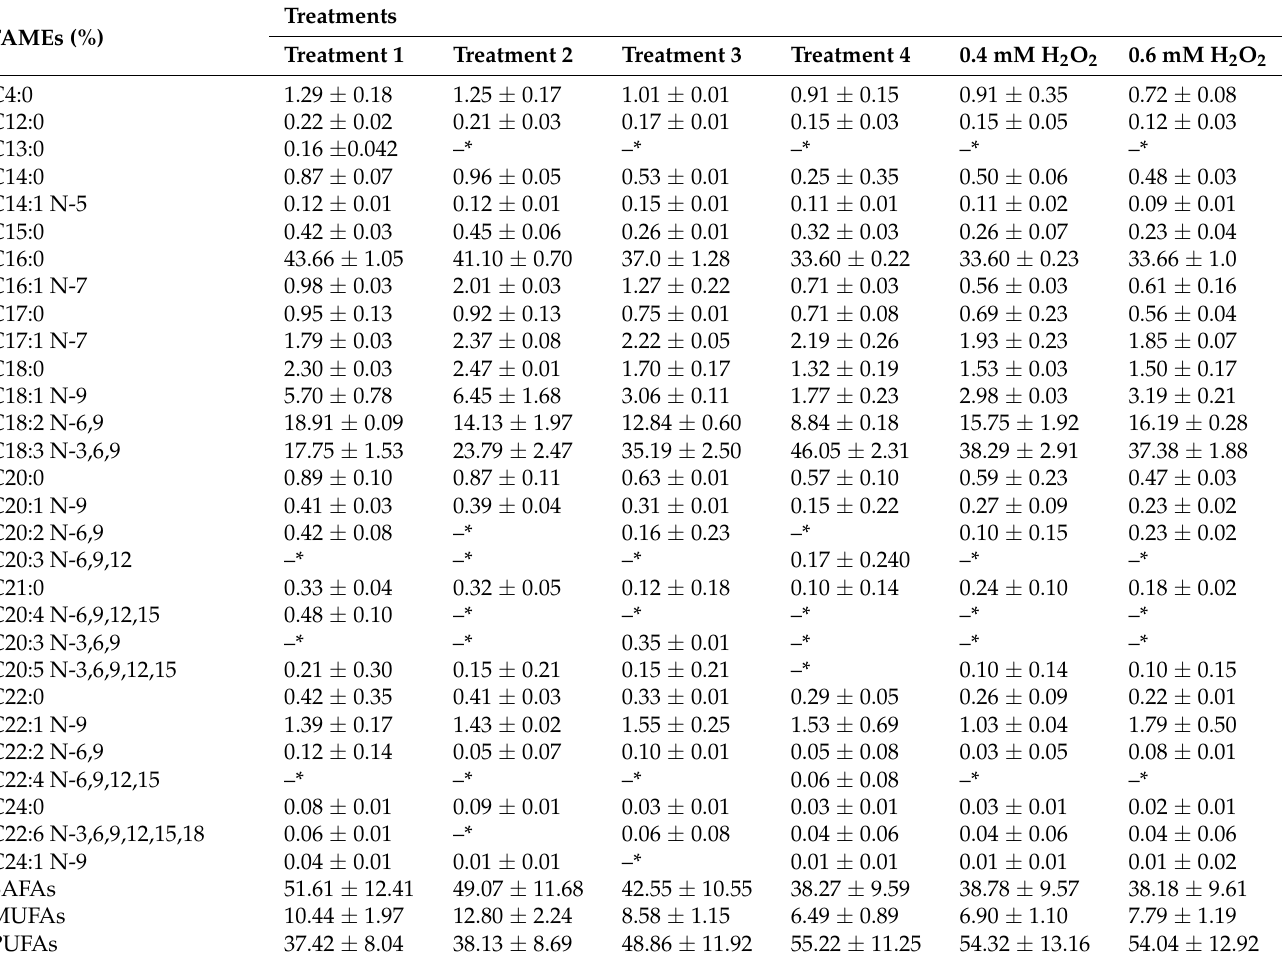
Table 1. Percentage of FAMEs in Chlamydomonas reinhardtii cells under different cultural